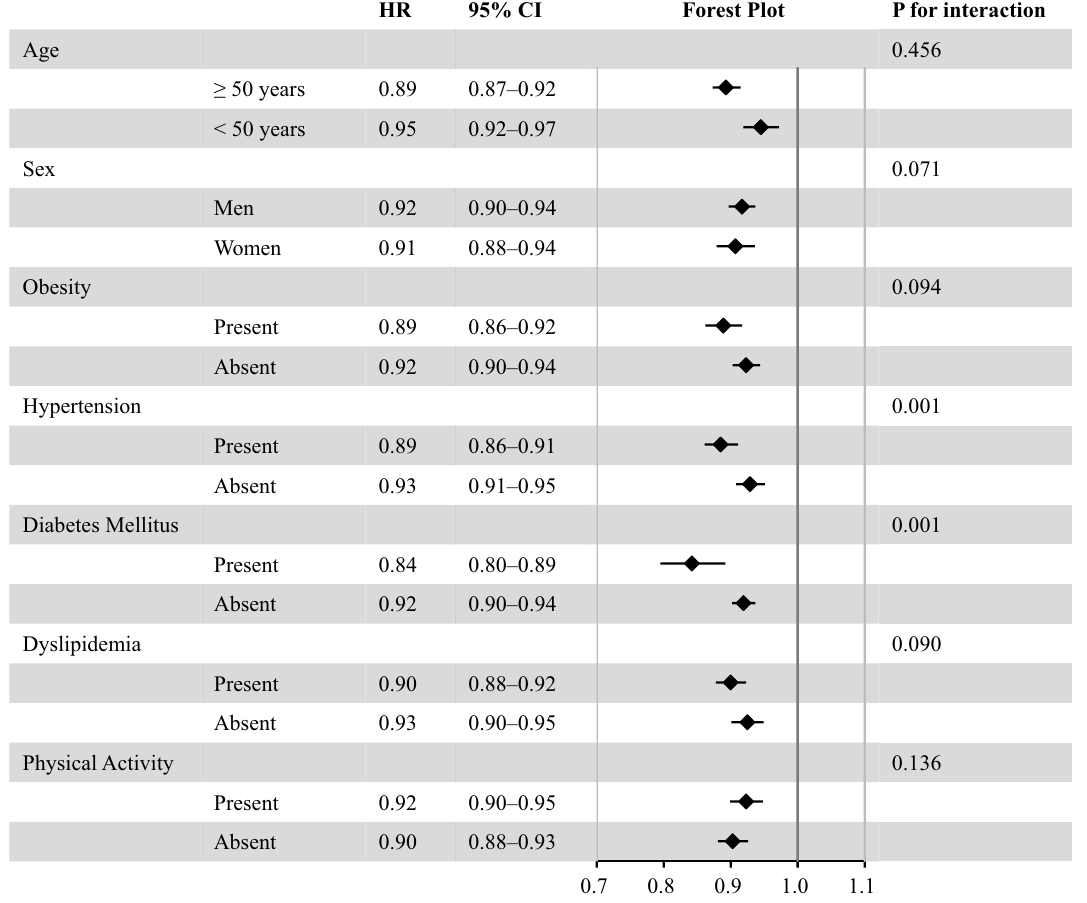
Figure 3. Hazard ratios of fast gait speed for the risk of heart failure in each subgroup. Adjusted with age, sex, obesity, hypertension, diabetes mellitus, dyslipidemia, cigarette smoking, and physical inactivity in the subgroup analyses stratified by age. Adjusted for age, obesity, hypertension, diabetes mellitus, dyslipidemia, cigarette smoking, and physical inactivity in the subgroup analyses stratified by sex. Adjusted with age, sex, hypertension, diabetes mellitus, dyslipidemia, cigarette smoking, and physical inactivity in the subgroup analyses stratified by the presence of obesity. Adjusted with age, sex, obesity, diabetes mellitus, dyslipidemia, cigarette smoking, and physical inactivity in the subgroup analyses stratified by hypertension. Adjusted with age, sex, obesity, hypertension, dyslipidemia, cigarette smoking, and physical inactivity in the subgroup analyses stratified by diabetes mellitus. Adjusted with age, sex, obesity, hypertension, diabetes mellitus, cigarette smoking, and physical inactivity in the subgroup analyses stratified by dyslipidemia. Adjusted with age, sex, obesity, hypertension, diabetes mellitus, dyslipidemia, and cigarette smoking in the subgroup analyses stratified by the presence of physical activity. HR Hazard ratio, CI Confidence